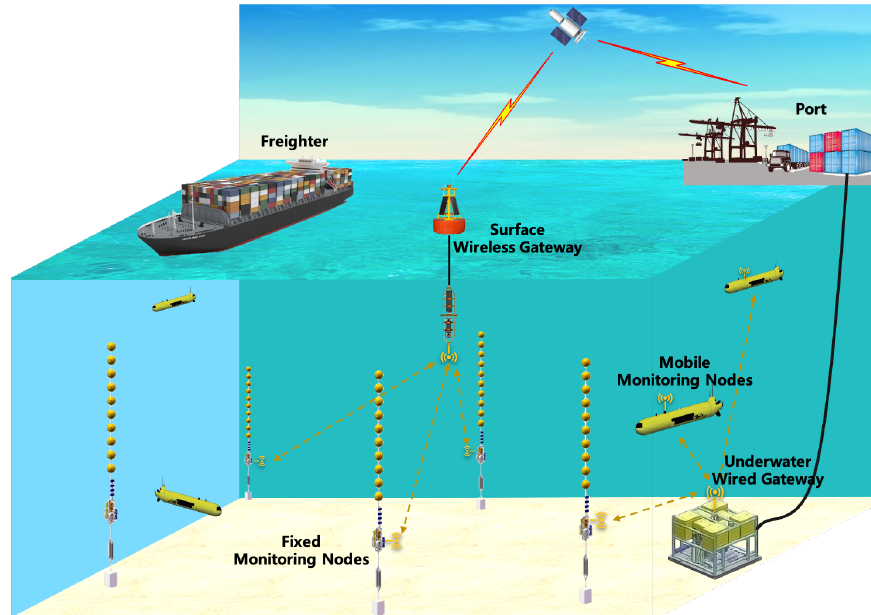
Figure 1. Underwater wireless monitoring network is used in port security